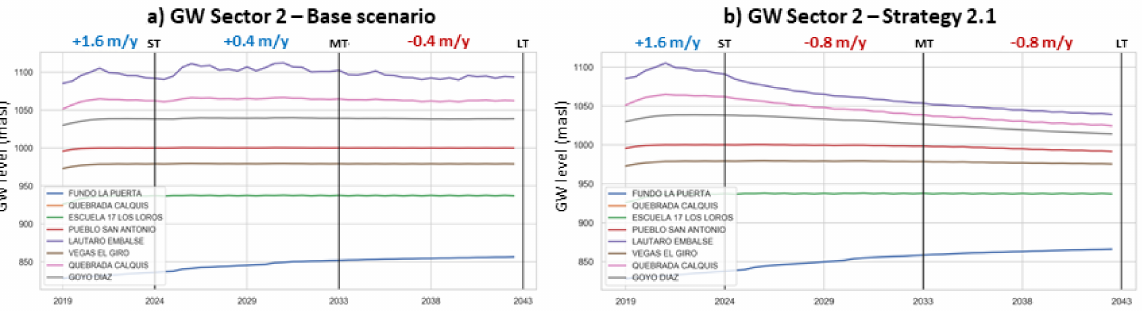
Figure 10. Time series of groundwater levels in representative observation wells located in the groundwater sector 2 for ( a ) base scenario, and ( b ) Strategy 2.1. ST: short-term, MT: mid-term, LT: long-term. Increasing average trend for each period for all observation wells in blue. Decreasing average trend for each period for all observation wells in